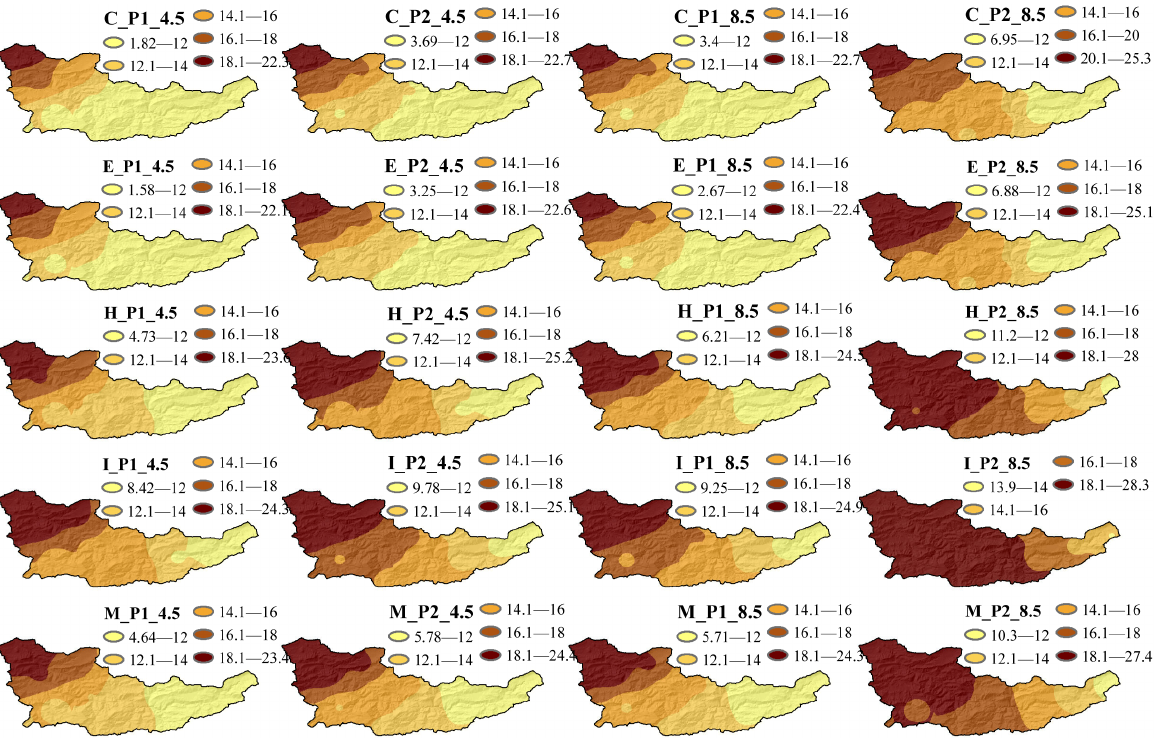
Figure 6. Future changes of temperature of the RCMs under RCP4.5 and RCP8.5 for the